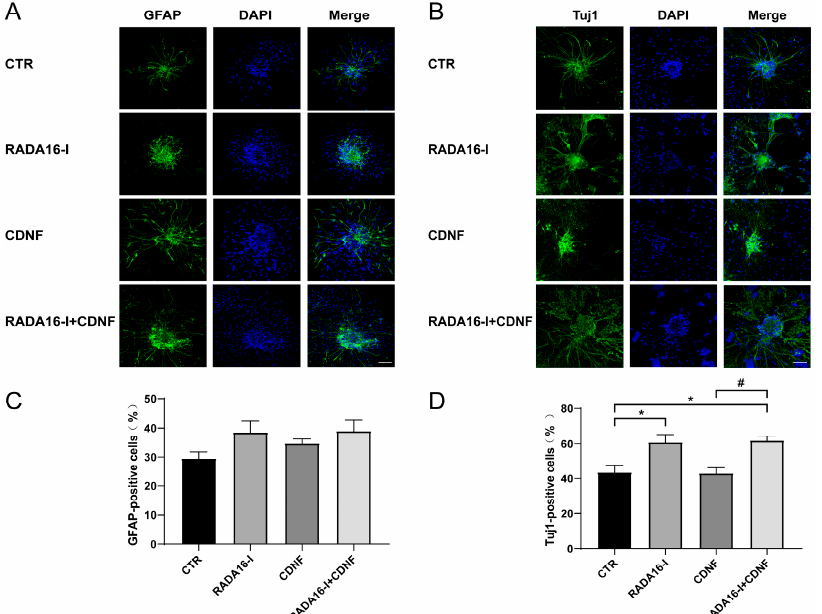
Figure 2. The effect of RADA16-I and CDNF on the differentiation of cultured NSCs. ( A ) GFAP-positive cells (green) were identified via immunohistochemical staining. DAPI (blue) was used to label the nuclei. ( B ) Tuj1-positive cells (green) were identified via immunohistochemical staining. DAPI (blue) was used to label the nuclei. ( C ) Quantitative analysis of the number of GFAP-positive cells. ( D ) Quantitative analysis of the number of Tuj1-positive cells. * p < 0.05 indicates statistical significance between treatment group and CTR group; # p < 0.05 indicates statistical significance between CDNF group and RADA16-I + CDNF group. Scale bar = 45 µm.